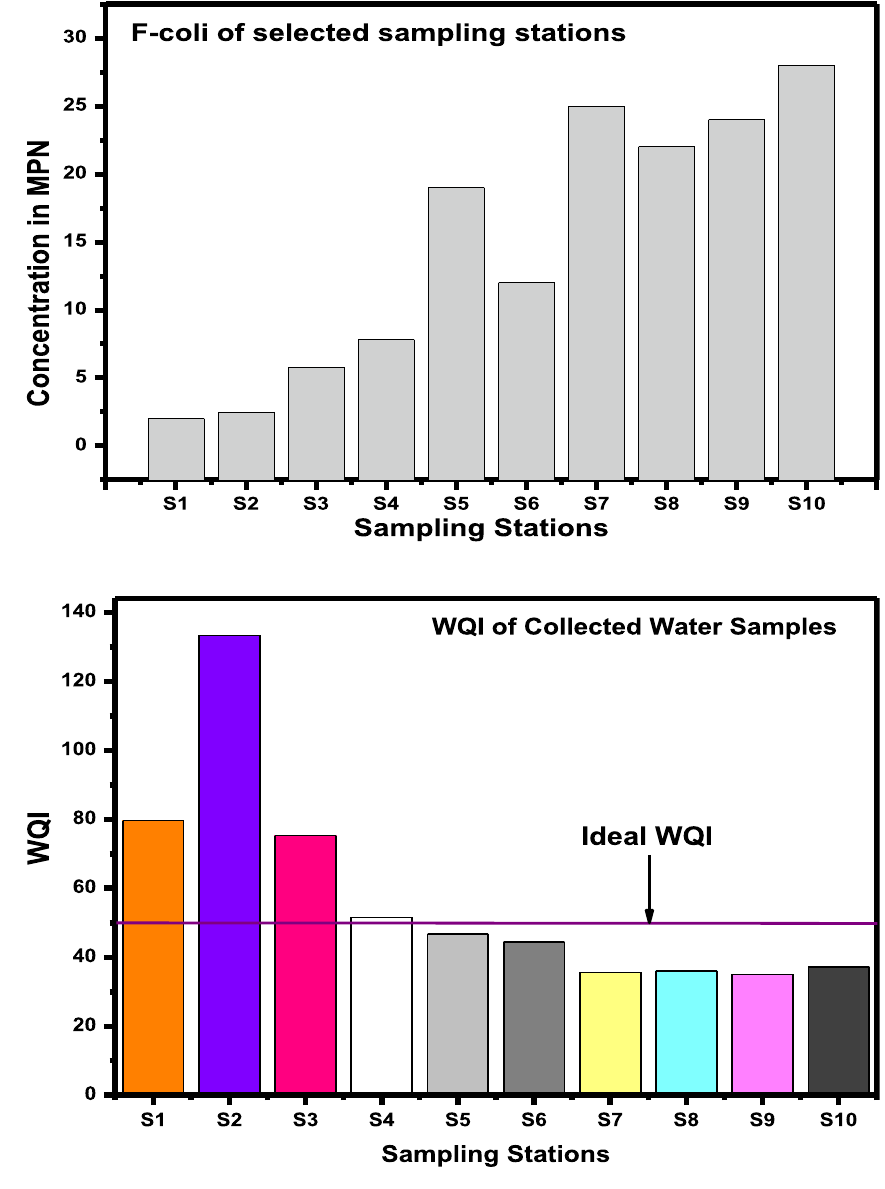
Fig. 8 F-coli of selected sam- pling stations